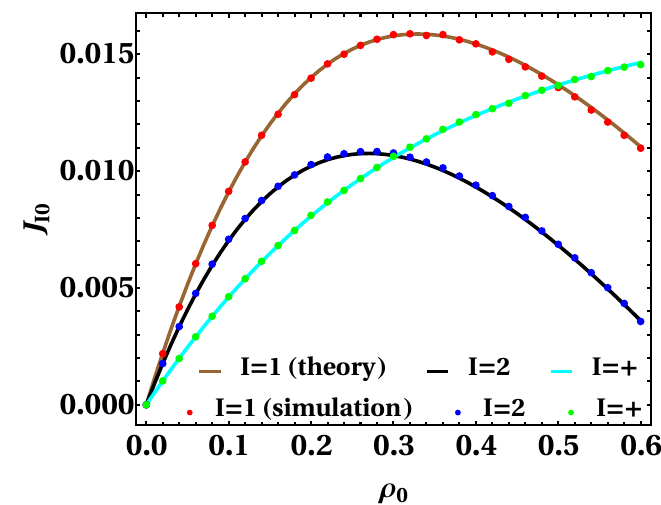
Figure 4: The figure illustrates the non-monotonic behaviors of the drift currents J ( I = 1,2) with increasing vacancy density ρ , unlike the I 0 0 drift current for the impurities J + which increases monotonically with in- 0 creasing ρ . The analytical results (solid lines) are in agreement with 0 the Monte Carlo simulation results (points). The parameters used are = 0.3, p = 1.0, ε = 0.1, w = 0.4, w = 1.0, ρ = 0.2. The ensem- L = 10 3 , p + 1 2 12 21 ble average is done over 10 5